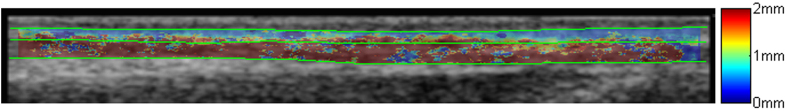
Displacement distribution of the locations along the tendon and its surrounding tissue in a healthy individual.The displacement is larger at most locations within the tendon than in the surrounding tissue (relative displacement ratio of >0.6).